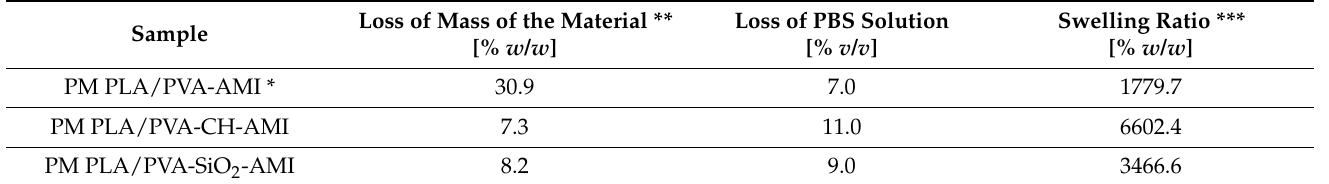
Table 7. Comparison of the loss of mass and sorption capacities of the porous matrices during immersion. Loss of Mass of the Material ** Sample